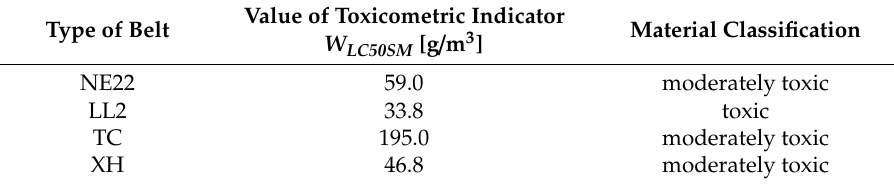
Table 5. Assessment of products of thermal decomposition and combustion of belts, in accordance with the classification criterion in PN-B-02855